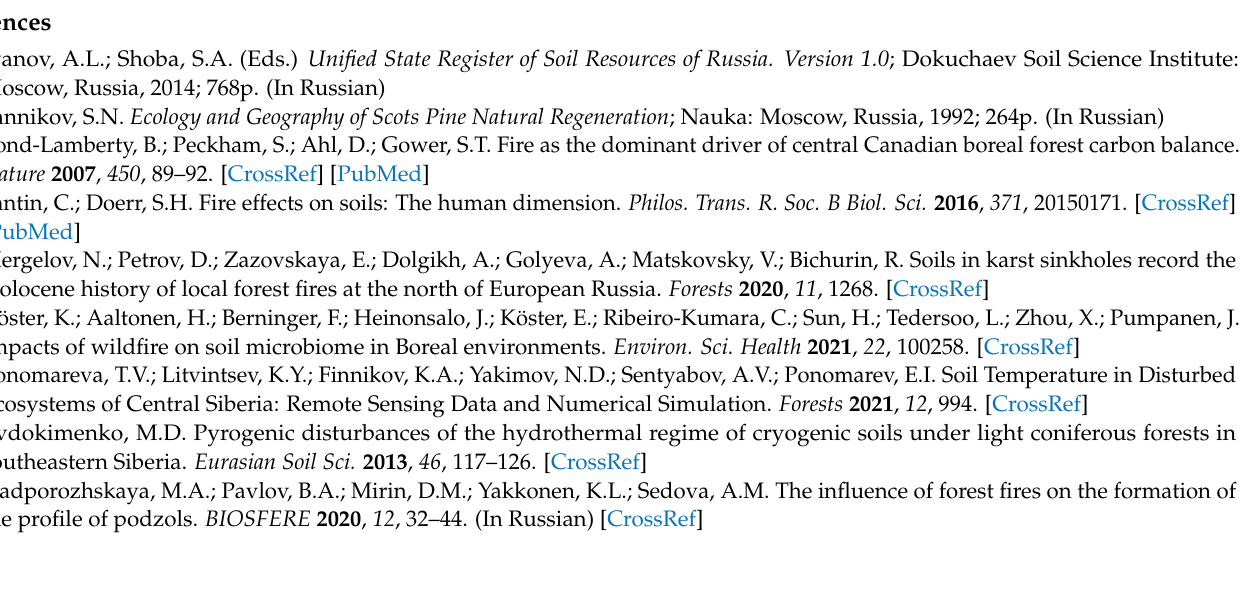
Table S1: texture of studied